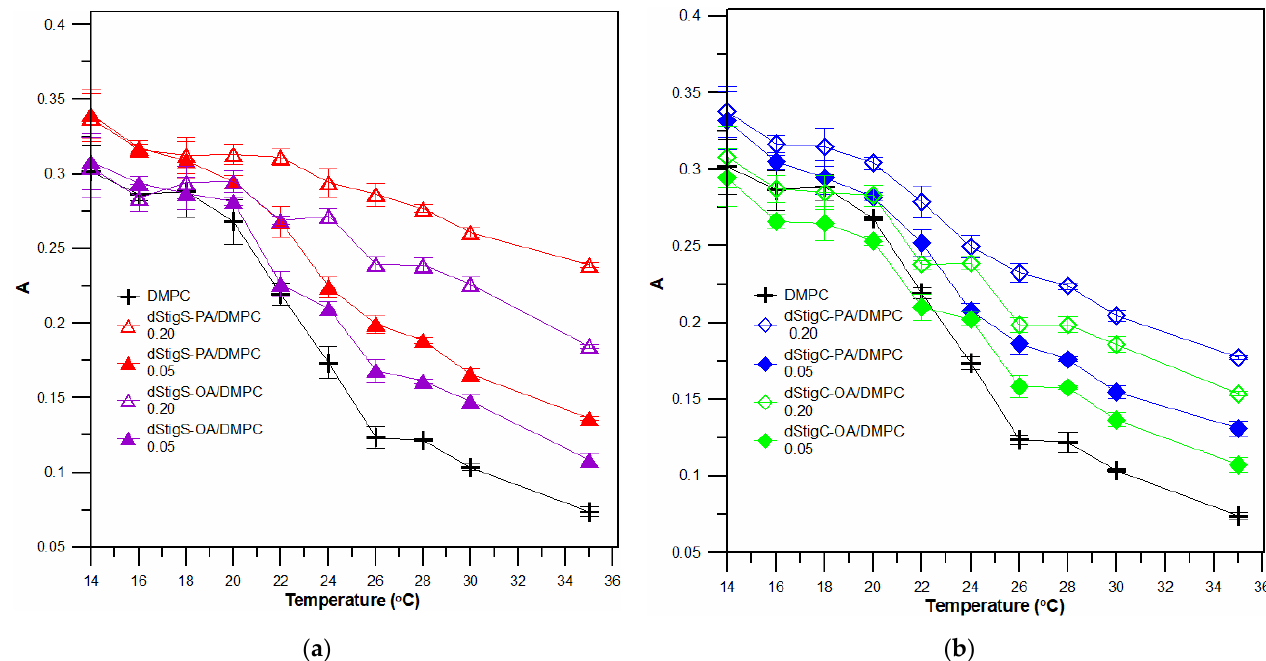
Figure 6. Values of anisotropy of DPH probe fluorescence as a function of temperature. ( a ) Measurements made for SUVs formed with DMPC, without and in the presence of dStigS-PA or dStigS-OA, for two molar ratios of dStigMAs /DMPC: 0.05 and 0.20. ( b ) Measurements made for SUVs formed with DMPC, without and in the presence of dStigC-PA or dStigC-OA, for two molar ratios of dStigMAs /DMPC: 0.05 and 0.20.